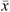
PALM imaging of MatP and z-position estimation.(A) Four representative PALM images for cells expressing MatP-mEos2 in the order of bright-field, ensemble fluorescence, and PALM image. Scale Bars, 500 nm. (B) Distribution of short-axis displacements of MatP-mEos2 clusters from the middle of the cell (yellow bars) fitted with a model (red line) in which a normally-distributed radial displacement is randomly projected to a 2D imaging plane (S1 Text). The fitted radial displacement is 285 ± 120 nm (red line, x- ± sd).